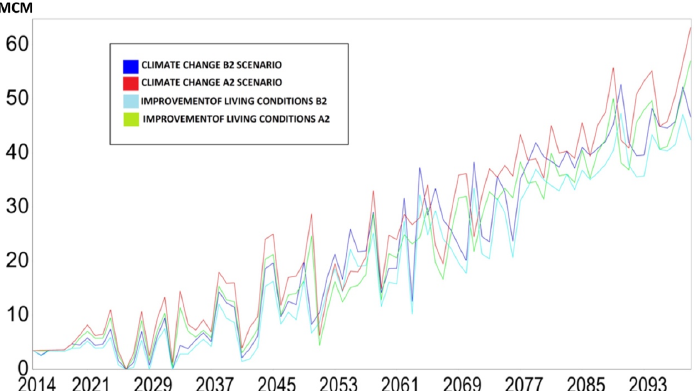
Figure 10. Change in unmet water demand under climate change scenario associated with improvement of living conditions. of living